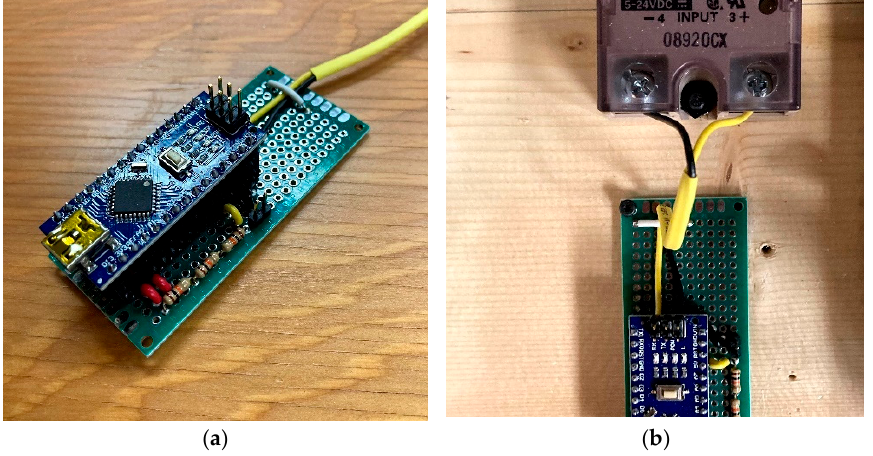
Figure 10. Assembly of the electronics for the thermal controller. ( a ) The Arduino installed on the circuit; ( b ) the signal wires attached to the relay.